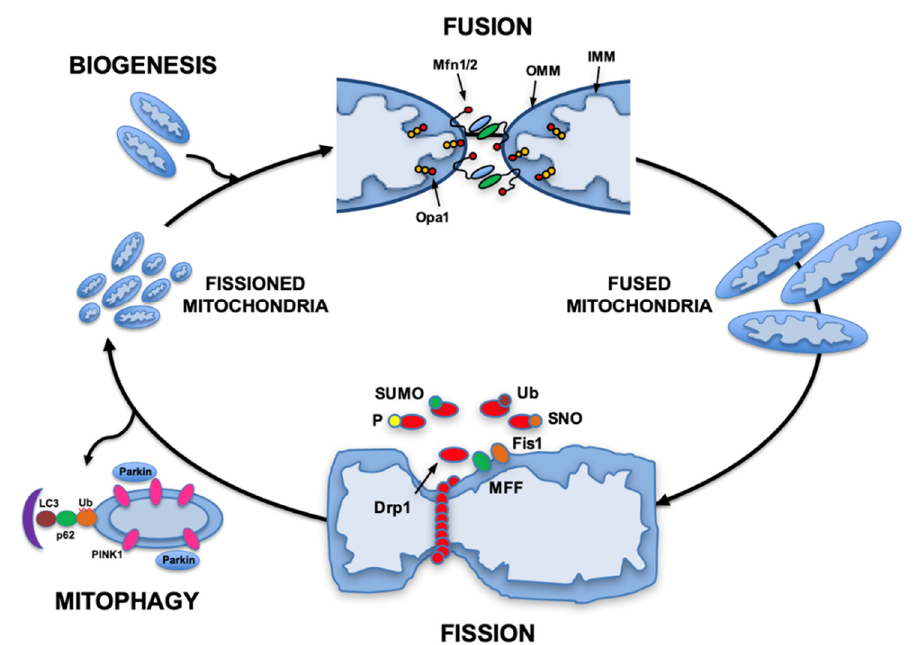
Figure 1. Mitochondrial dynamics and quality control. The mitochondrial remodeling processes of fission and fusion are both involved in regulating mitochondrial quality control. Mitochondrial fission is regulated by the interaction of mitochondrial proteins (Fis1 or MFF) with the cytosolic protein Drp1, which is translocated from the cytosol to the mitochondria fraction. This process is regulated by several different post-translational modifications (phosphorylation, sumoylation, s-nitrosylation and ubiquitination). During pathological stress, such as induced by ischemia-reperfusions, mitochondria with low membrane potential are marked for mitophagy by accumulation of Pink1, recruitment of Parkin, and are eliminated through autophagy. Mitochondrial fusion is regulated by the interaction of mitochondrial inner (Opa1) and outer membrane proteins (Mfn1/2). Mitochondrial biogenesis is the process that results in synthesis of new mitochondrial proteins and is regulated by the PPARγ coactivator transcriptional coactivators PGC-1α, PGC-1β, and PGC-related PRC. Abbreviations: Drp1, dynamin-related protein 1; Fis1, mitochondrial fission protein 1; IMM, inner mitochondrial membrane; LC3, Microtubule-associated proteins 1A/1B light chain 3B; MFF, mitochondrial fission factor; MFn, mitofusin; OMM, outer mitochondrial membrane; Opa1, optic atrophy 1; PGC-1, Peroxisome proliferator-activated receptor gamma coactivator 1; PINK1, PTEN-induced putative kinase 1; PPARγ, Peroxisome proliferator-activated receptor gamma; PRC, PGC-1-related coactivator; SNO, S-nitrosylated ; SUMO, small ubiquitin-like modifier protein; Ub, ubiquitin. (From Gottlieb and Bernstein [3]. Based in part on Archer et al. [4]).